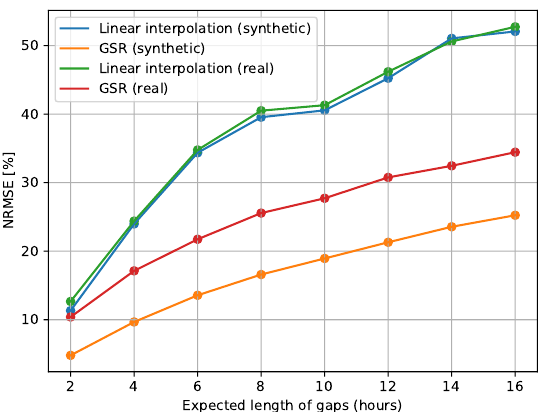
Figure 6. Daytime normalized root-mean-square error (NRMSE) for signal reconstruction against expected length of gaps (in hours) per day in the data for both the real and synthetic datasets. “GSR” stands for the graph signal reconstruction technique introduced in this paper.